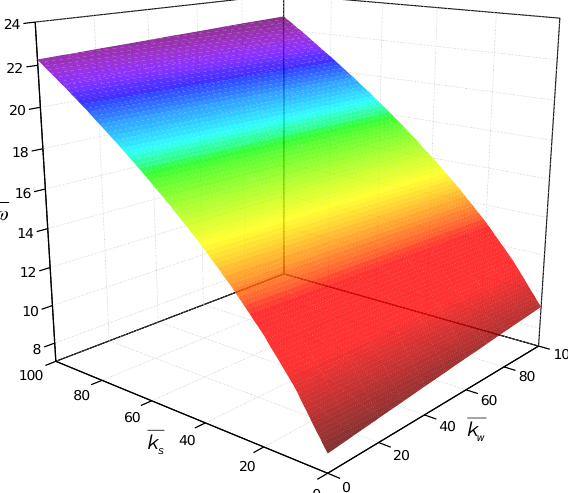
Figure 3. The influence of elastic foundation parameters ( K w , K s ) on the natural frequency (cid:1)(cid:112) (cid:0) ω = ω a 2 / h ρ / E of functionally graded ( Al / Al 2 O 3 ) plates ( p = 2, a / h = 10 ) .